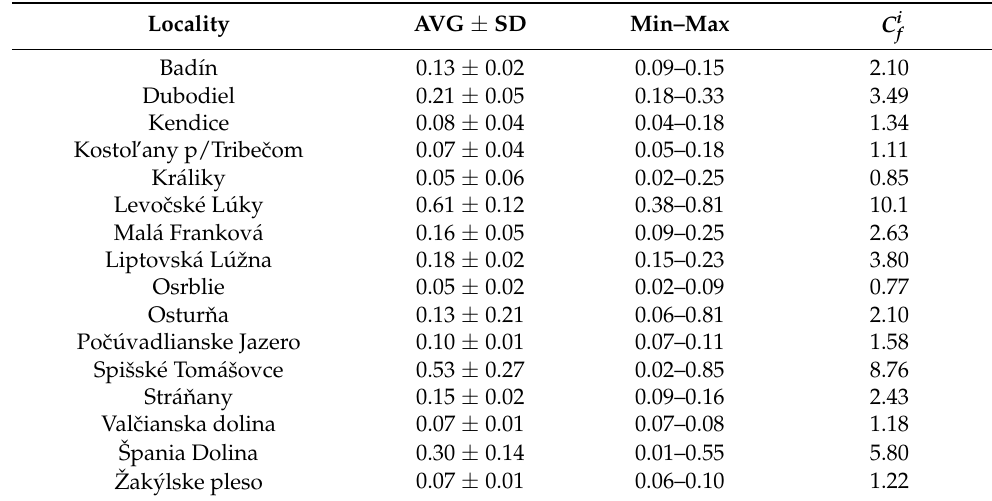
Table 2. Mercury content in soil/substrate (mg kg − 1 DW) and contamination factor of soil in the studied